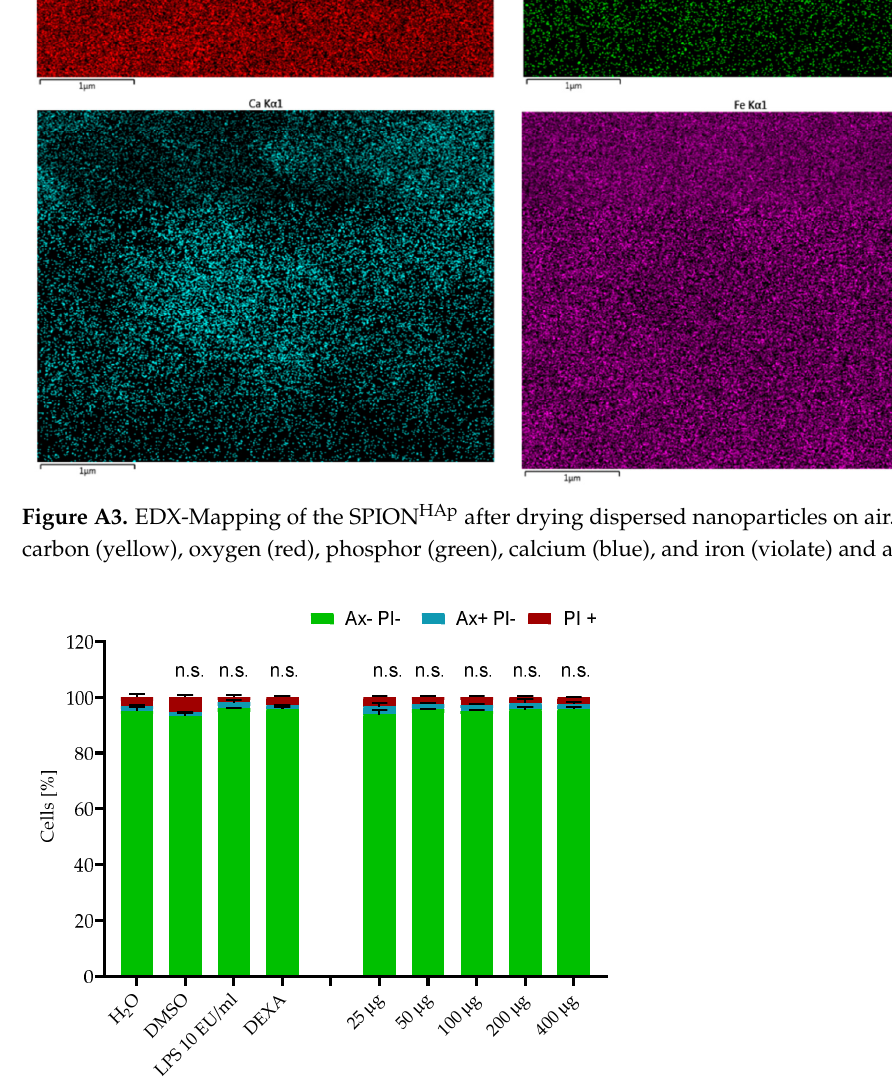
Figure A4. Effects of SPION HAp on the viability of EL4 cells (ATCC ® TIB-39™). Cells were incubated with SPION HAp particle concentrations of 25 to 400 µ g/mL and additional controls of H 2 O, DMSO